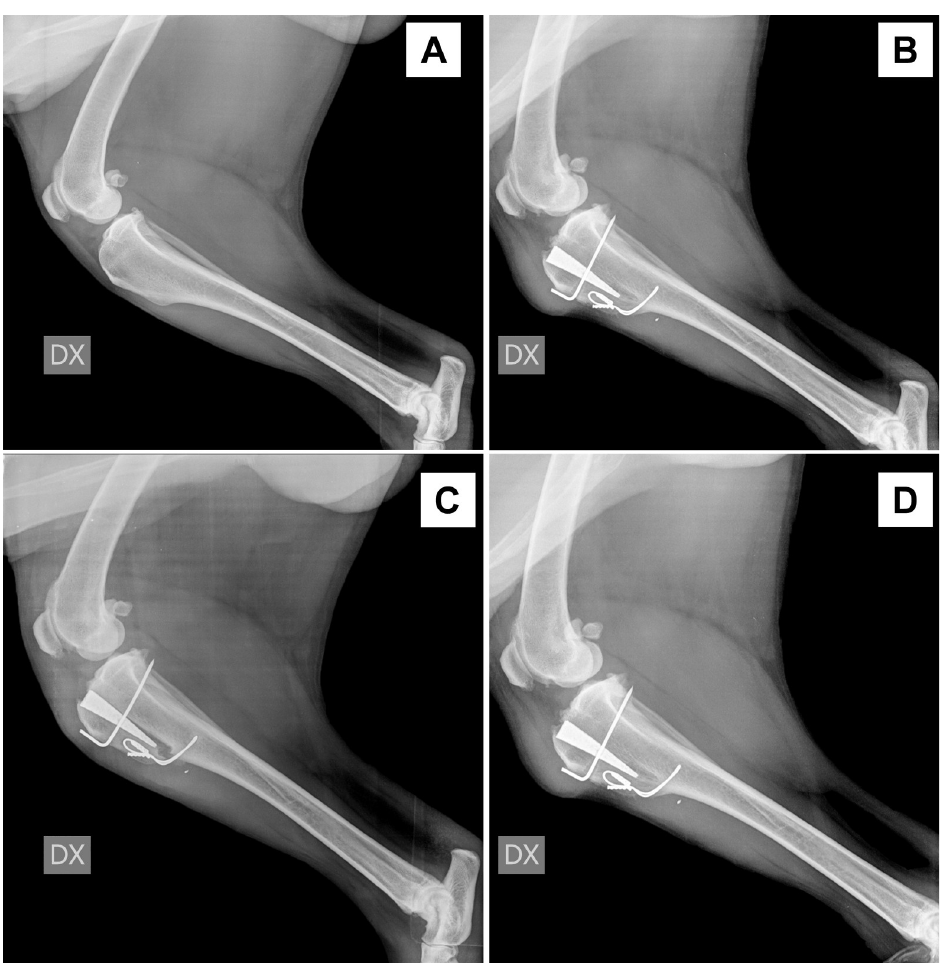
Fig 2. Radiographic evaluation of tibial tuberosity fracture over time intervals. Fig 2 A: preoperative radiograph (T0), B: immediate postoperative (T1), C: 30-days after surgery (T2), D: 90-days after surgery (T3).